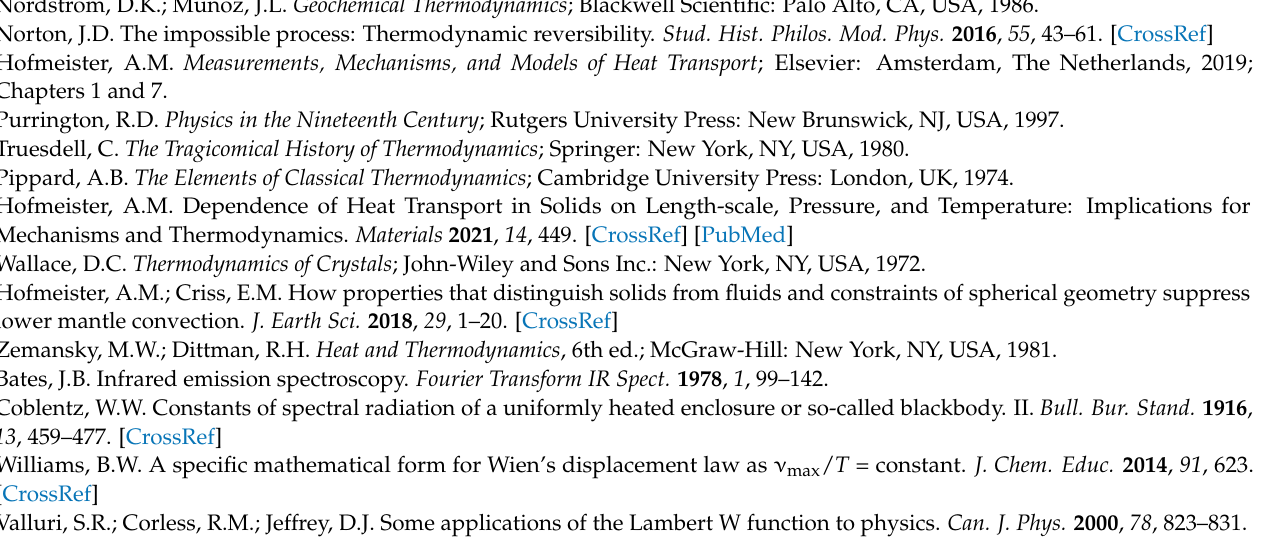
black curves and points = volumetric thermal expansivity. Right axis: grey curves and points = specific heat. Scales were chosen to best match α and c P at cryogenic T . Properties are at ambient conditions, taken from various compilations. ( a ) Aluminum. Squares = α [97]. Diamonds = recommended α [37]. Grey solid curve = c P compiled and evaluated by Desai [98]. Dashed = laser-flash calorimetry [99]. ( b ) Iron. Thick vertical bars mark structural phase transitions. X = capacitance measurements of α [100]. Squares = dilatometry [101]. Diamonds = recommended c P [39]. Grey curve = c P com- piled and evaluated by [102]. ( c ) Molybdenum. + = recommended fit to α [37]. Circles = XRD results compiled and evaluated by Wang and Reeber [103]. Squares = transient interferometry [104]. Diamond = dilatometry data [105]. Grey curve = c P compiled and evaluated [106]. ( d ) Tantalum. Diamonds = capacitance measurements of α [107]. + = fit to recommended values [37,96] by [94]. Squares = transient interferometry [108]. Light grey line = cryogenic calorimetry data [109]. Grey long dashes = laser flash calorimetry [110]. Grey short dashes = pulse calorimetry [111]. Dark grey line = pulse calorimetry [112]. ( e ) Gold. Black dots = tabulated α [113]. Triangles, α obtained by differentiating tabulated volumes of Pamato et al. [114]. Thin line = α from 2nd order polynomial fit to V [114]. Open diamonds = recommended fit to α [94]. Squares = dilatometry and XRD data from Suh et al. [105]. Thick grey line = raw c P data [115]. Dotted line = mid-range of adiabatic calorimetry data [116]. Grey squares = pulse calorimetry [117]. ( f ) Diamond. Black diamonds = α from Slack and Bartram [117], who combined 10 XRD studies of large natural crystals. Thin curve = recommended α [37]. Solid grey curve = c P [118]. X = DSC [119]. Dots = drop calorimetry of Victor [120], who stated air leakage occurred for the highest T points. Square with cross = Weber [121], who heated his samples in air. Dashed line = modulated DSC data [122], which are not absolute. ( g ) Si. Black curve = rec- ommended α [123]. Squares = single-crystal α [124]. Grey curve = c P compiled and evaluated [102]. ( h ) Alkali halides. Solid lines = NaCl data: black = α [80]; grey = c P [81]. Dashed lines = compiled KCl data [54]. ( i ) MgO. Solid curve, α as tabulated in [125] which has an inflection point (arrow) at 1000 K instead of a sway. The kink may be exaggerated, due to low and high T segments probing crystals and ceramics, respectively. Open squares = cryogenic data [126,127]. Short dashes = 2nd order polynomial fit to tabulated XRD data [93], acquired using an Ir wire heater. Grey dots = c P from [128]; triangles from [129], obtained by differentiating heat content; solid = Chase’s [130] review, where the high T trend is an extrapolation. ( j ) Al 2 O 3 . Circle = α from powder XRD compiled and evaluated [131]. + = α compiled and evaluated [132]. Thin line = linear description of high T powder XRD [93]. Squares = single-crystal interferometry and twin telemicroscope measurements [133]. Grey curve = c P compiled and evaluated by [134]. ( k ) Yttrium aluminum garnet. Diamonds = interferometry of a single-crystal [135]; squares = transparent polycrystal [136]. Black curve = from XRD [137]. Grey curves = DSC data: solid = [138]; dashed =